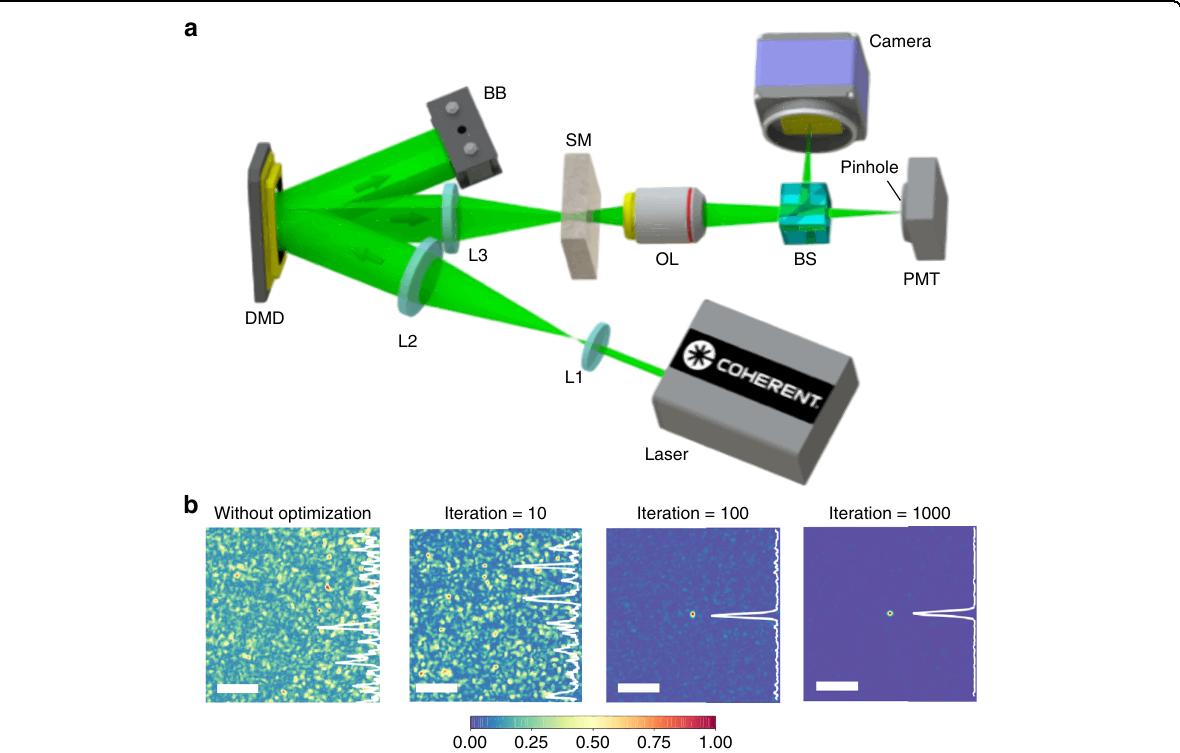
Fig. 3 Demonstration for the DMD-SNES-based WS. a Setup of the experiment. L, lens; DMD, digital-micromirror device; BB, beam blocker; SM, scattering medium; OL, objective lens; BS, beam splitter. b Normalized intensity distribution of the images captured by the camera before the optimization, and after 10, 100, and 1000 iterations (from left to right). The white curve on the right-hand side of each image shows a normalized light intensity distribution along the central vertical line. Scale bar, 500